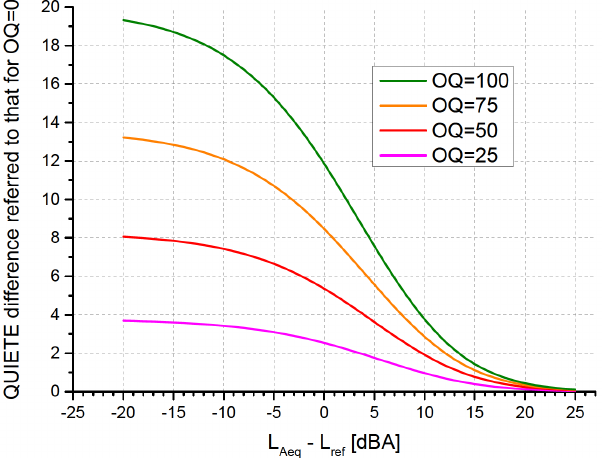
Figure 2: Differences of QUIETE values referred to that calculated for OQ = 0.